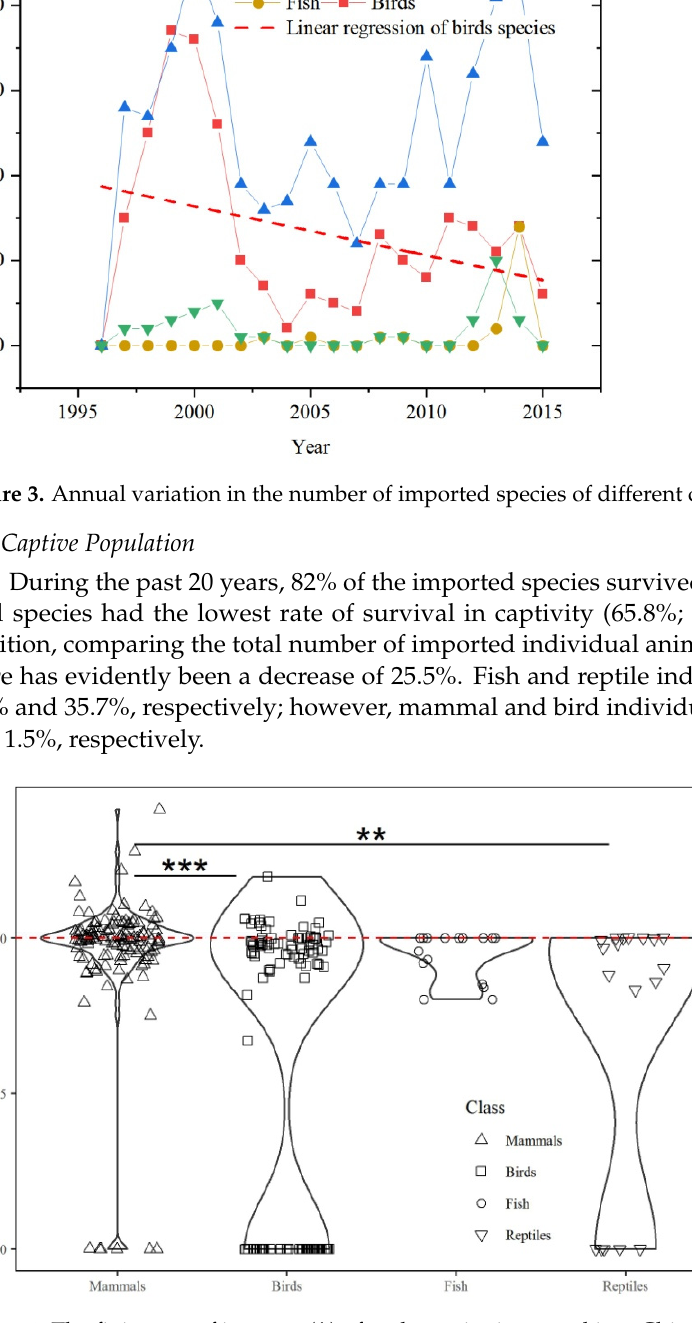
Figure 2. Annual variation in the number of imported species and individuals in China (1996–2015). Note the primary y axis scale.